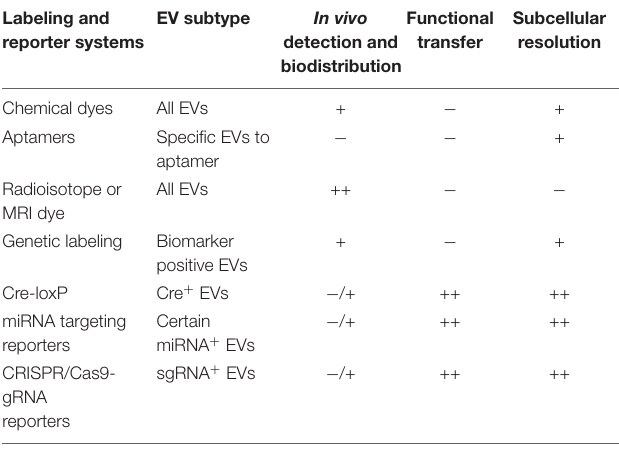
TABLE 1 | Labeling and reporter systems for evaluation of EV transfer. Labeling and EV reporter systems